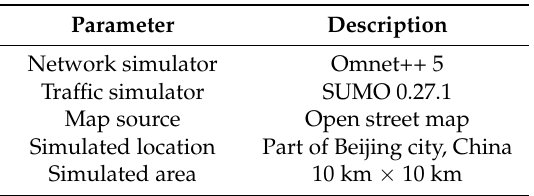
Table 3. Simulation